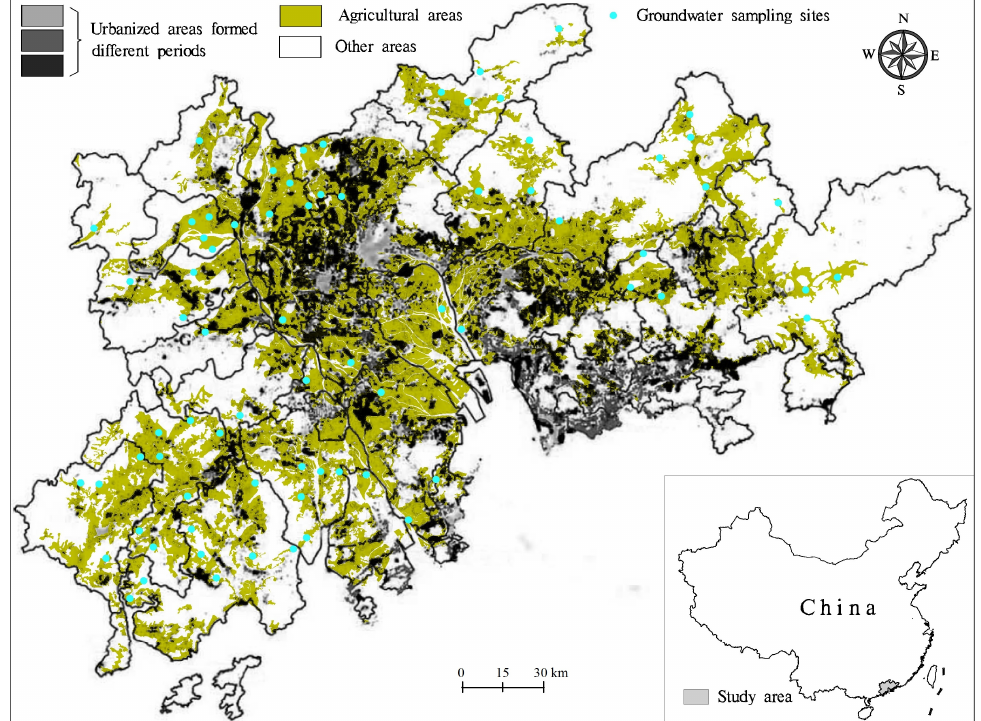
Figure 1. Groundwater sampling sites in agricultural areas in the Pearl River Delta (original data from [11]).